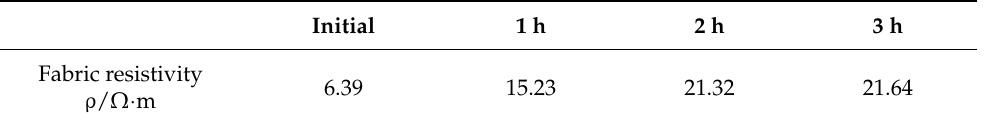
Table 2. The resistivity of conductive fabric soaked in NaCl solution for different